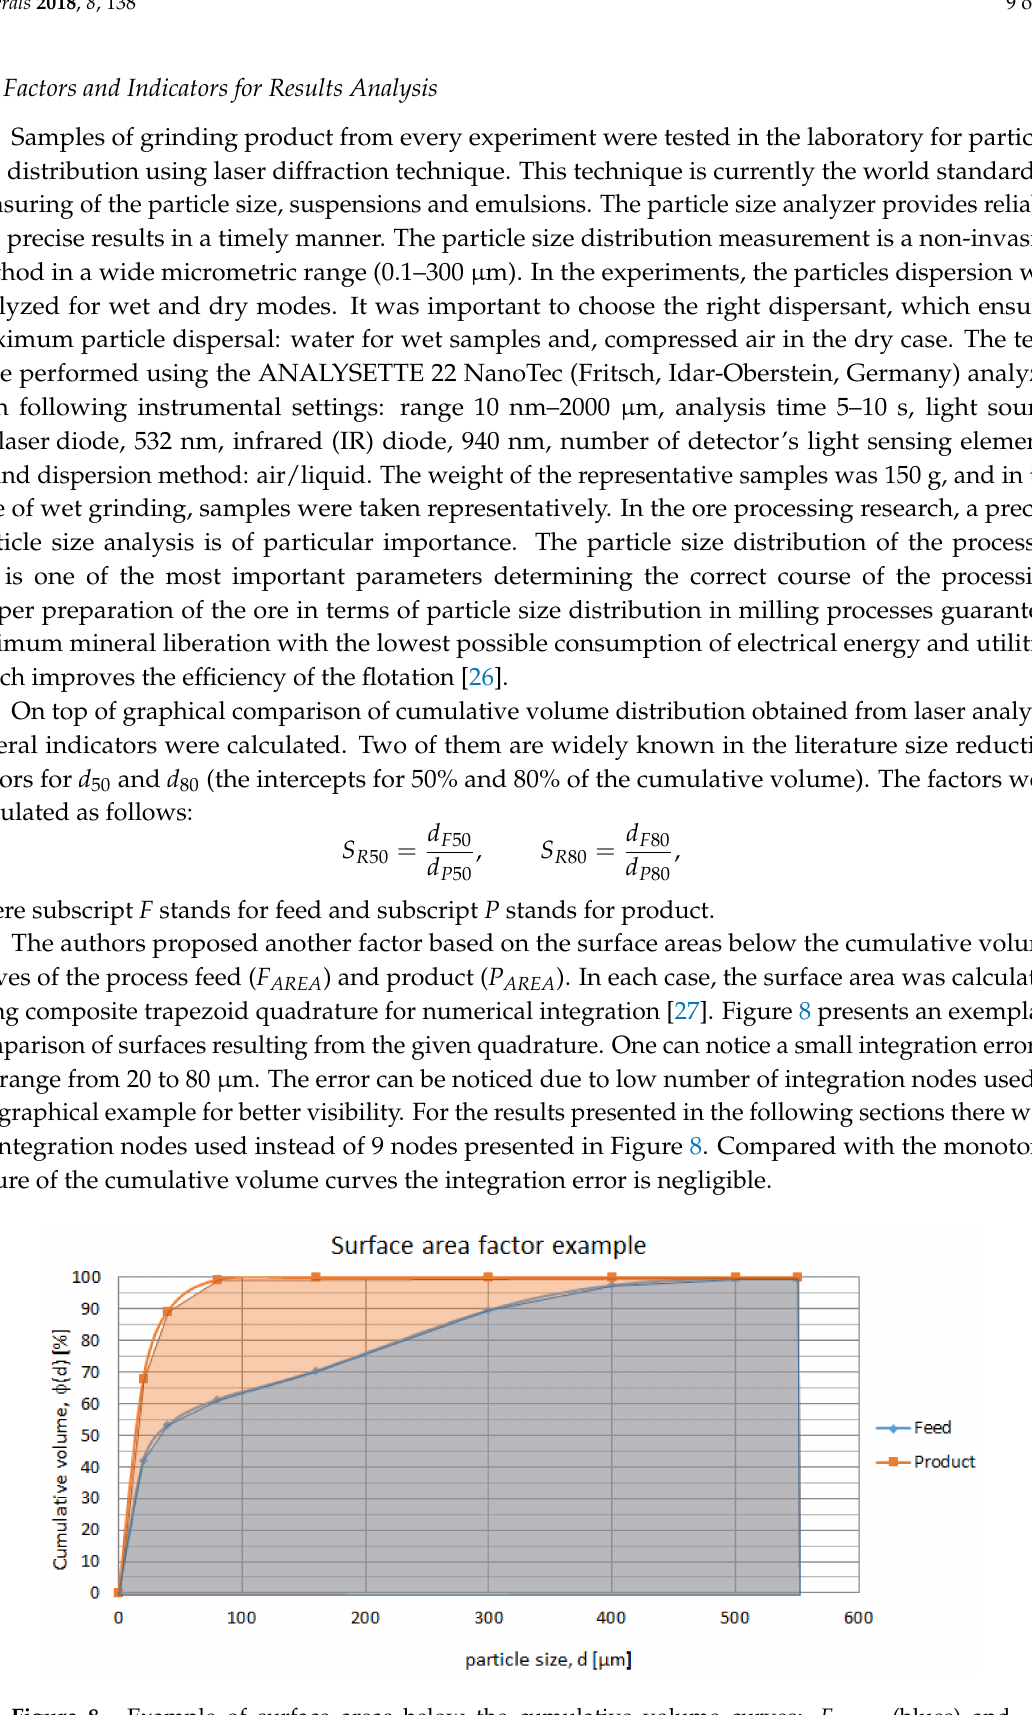
Figure 8. Example of surface areas below the cumulative volume curves: F AREA (blues) and P AREA